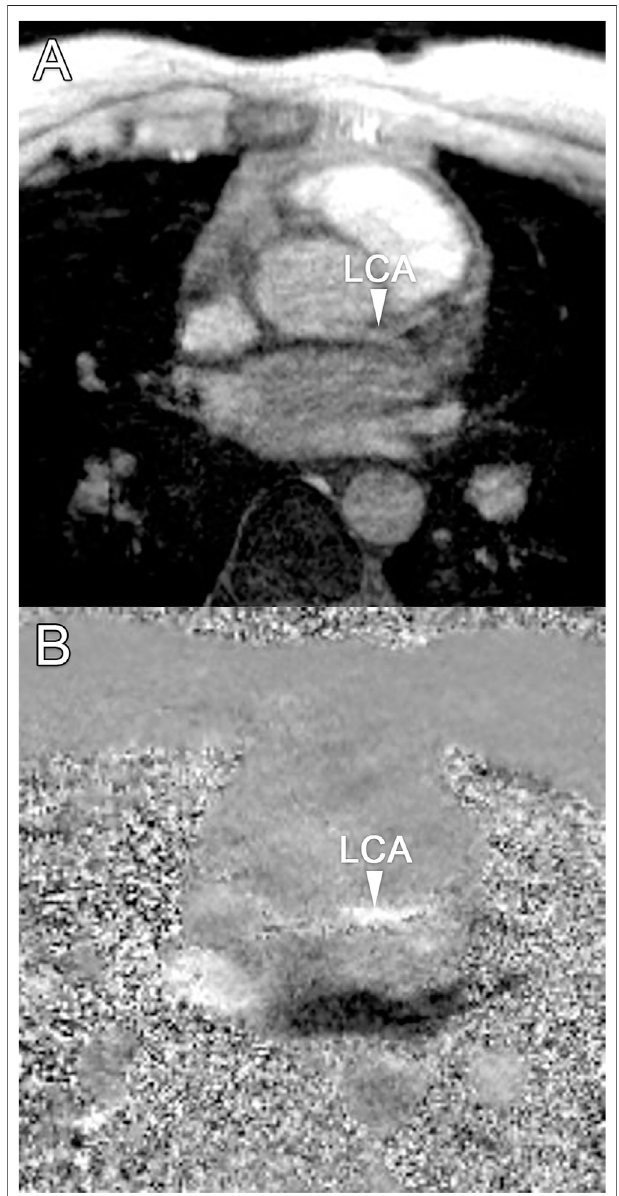
FIGURE3|(A) Transversal4D fl owMRImagnitudeimageand (B) phase image showing velocities in right-left direction during mid-diastole. Arrows indicate the location of the left coronary artery, where velocity signal can be observed.